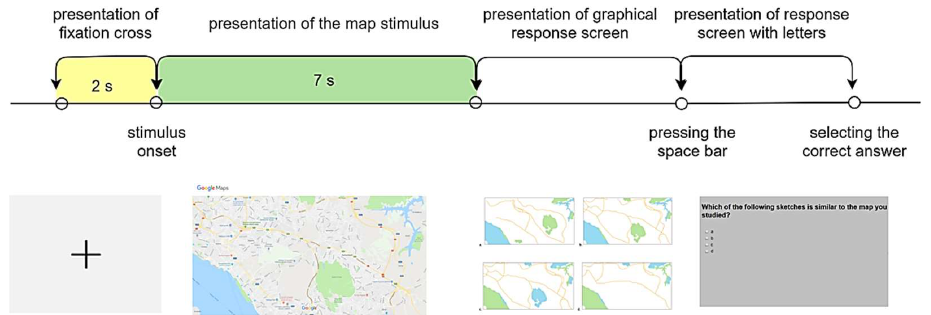
Figure 3. Experiment